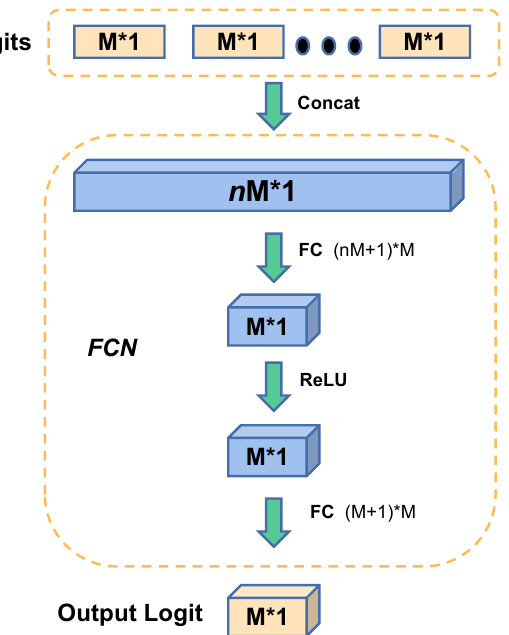
Figure 4. The framework of the Fully Connected Network.